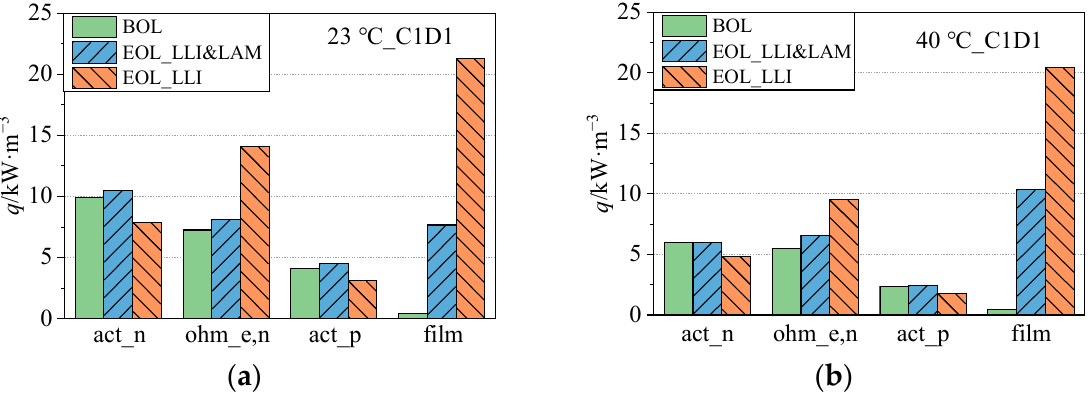
Figure 18. Comparison of the main heat generation items during the discharging process when the cell ages to EOL under different aging modes at ( a ) 23 °C and ( b ) 40 °C.